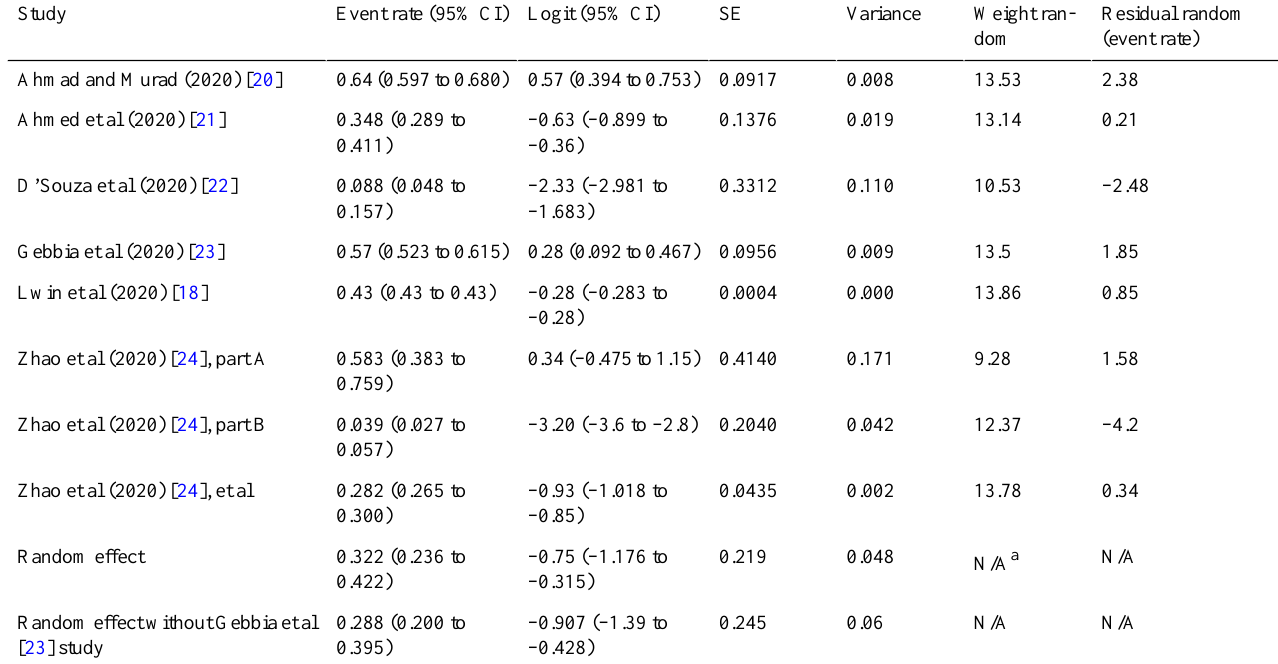
Table 2. Meta-analysis results.